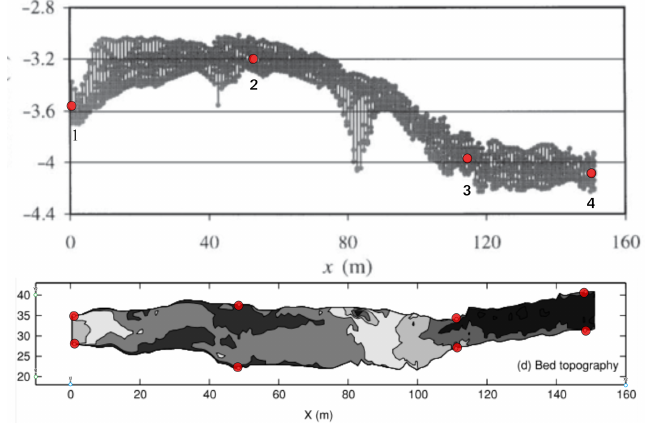
Figure B3. Modified Figs. 4 (top) and 3 (bottom) of Cao et al. (2003) showing the locations of channel width and elevation profile measure- ments indicated by the open circles. The bed elevation series is at the top of the image and the width series is at the bottom. Here channel width was measured as the distance in between the points at the two bounding edge positions at a given channel station. Units are meters. Flow is left to right in the image.